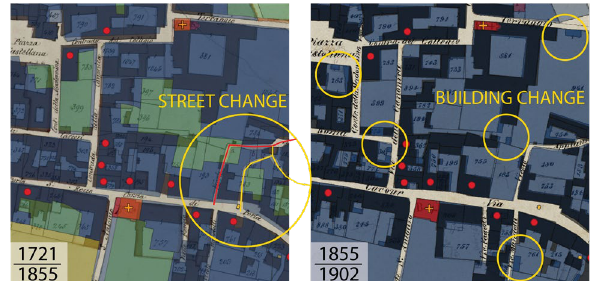
Figure 10. Comparison of historical maps. Changes in the streets’ distribution and modification of buildings (enclosing an inner courtyard with service buildings). Source: ASMi, Authors